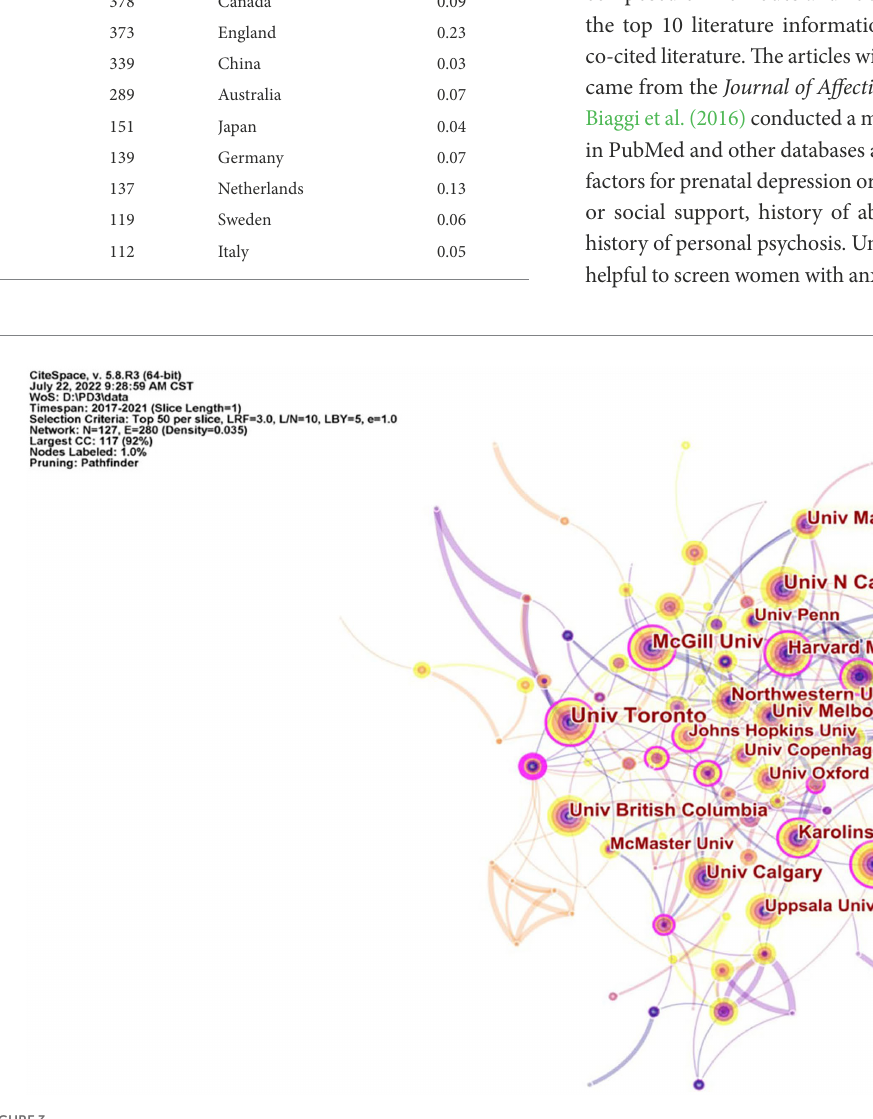
FIGURE 3 The cooperation network map of